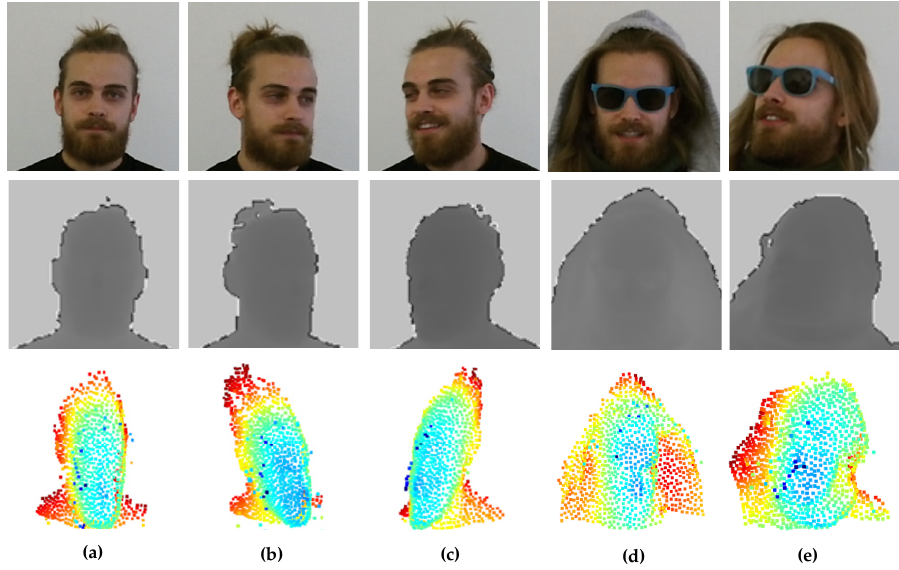
Figure 10. Example of Pandora split, where ( a – e ) represent the sequence S 1 , S 2 , S 3 , S 4 , and S 5 , respectively, where the subset ( a – c ) contains constrained movements and subsets ( d , e ) contain complex movements and occlusions.